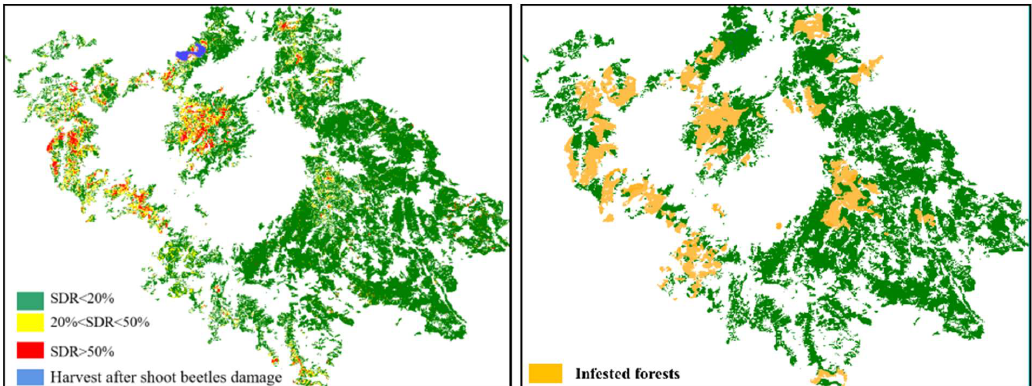
Figure 6. Comparison of the predicted area ( left ) and observed area ( right ) of beetle infestation in 2010.